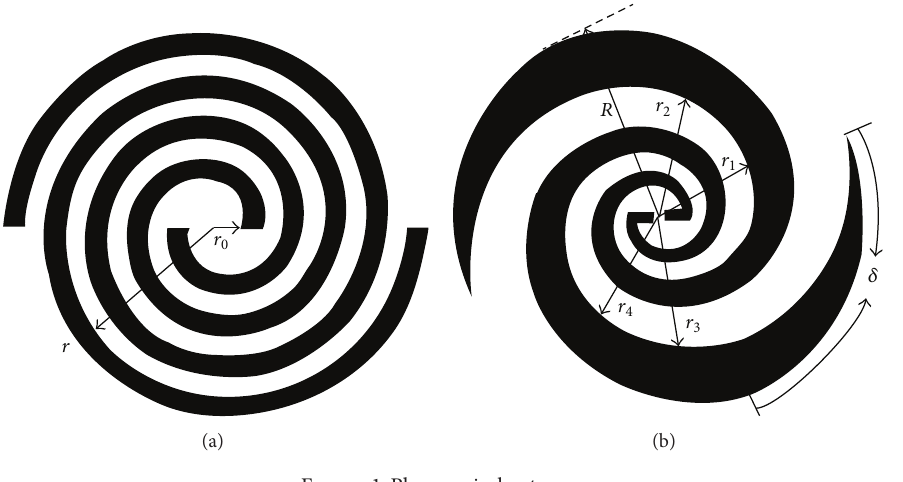
Figure 1: Planar spiral